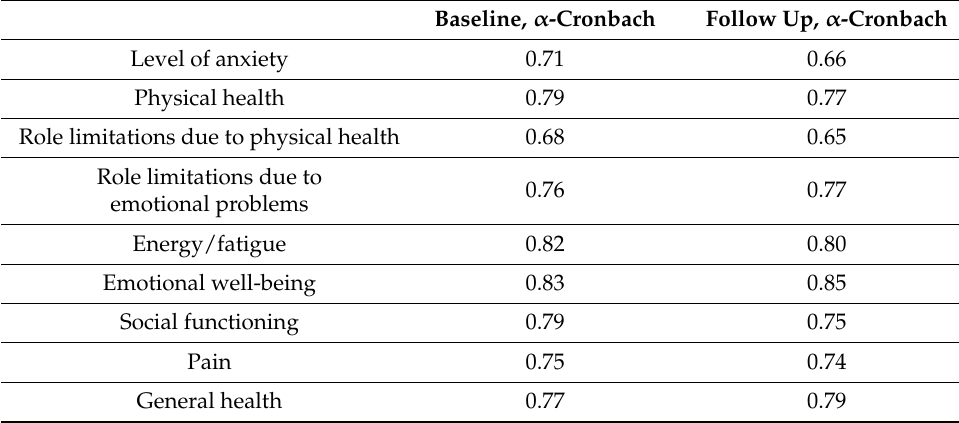
Table A2. Reliability of the study inventories, by time